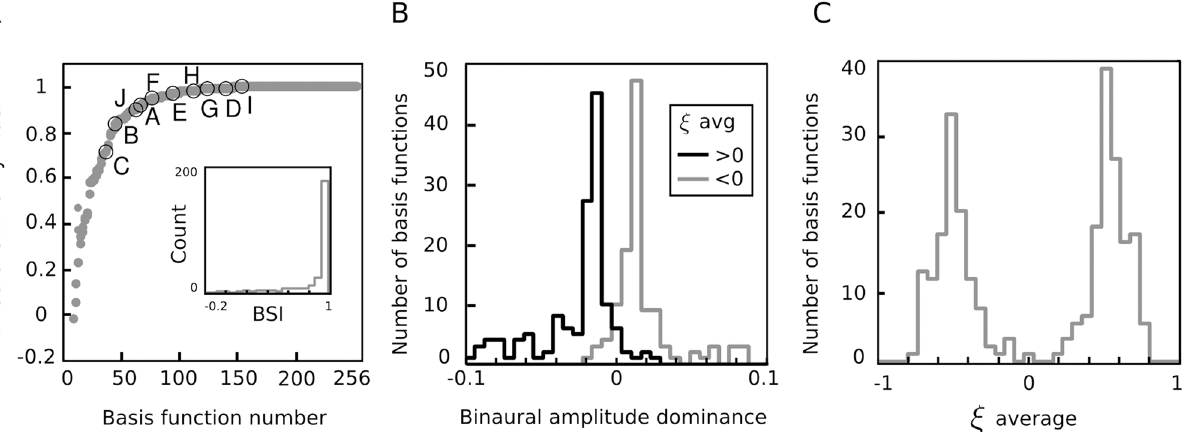
Fig 6. Binaural properties of the representation. A) Binaural Similarity Index of amplitude basis functions B i . The BSI is a correlation coefficient between left and right ear subvectors. The inset depicte the BSI histogram. B) Distribution of binaural amplitude dominance. Values above 0 imply domination of the left, and below 0 of the right ear. Histograms of BAD values of amplitude basis functions associated with negative IPD basis functions are colored gray and those associated with positive ξ i values are colored black. C) Distribution of averages of normalized ξ i basis functions.